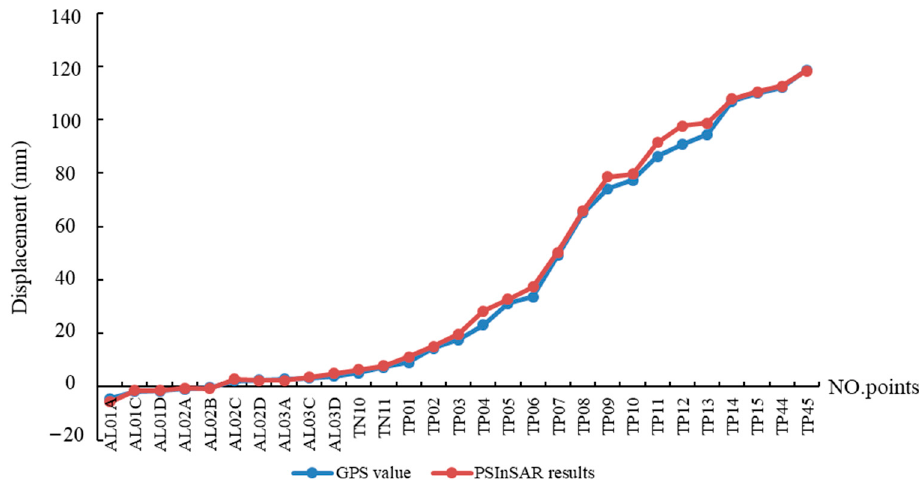
Figure 4. Monitoring results of GPS and permanent scatterer interferometric synthetic aperture radar (PSInSAR) data.